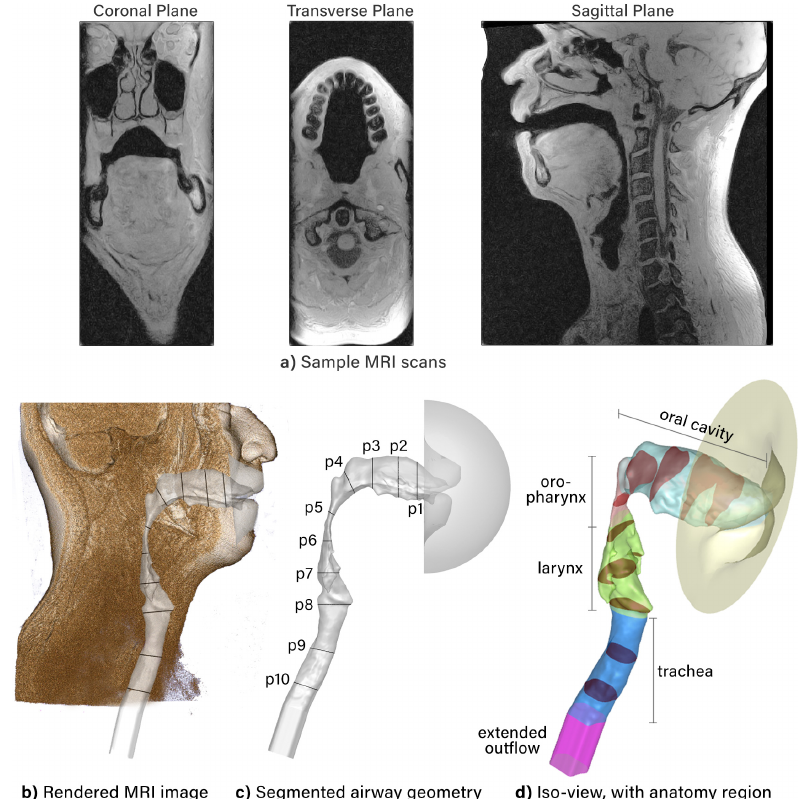
Figure 7. Airway geometry. ( a ) Sample MRI scans depicted in the coronal, transverse, and sagittal planes. ( b ) Three-dimensional rendered image from MRI scans with the segmented airway overlayed. ( c ) Segmented airway geometry labeled with cross-sectional planes (p1 to p10) from the oral cavity to the trachea. ( d ) Isometric view of the airway model showing the shape of the cross-section planes. Separated anatomical regions are colored as follows: light blue = oral cavity; red = oropharynx; green = larynx; dark blue = trachea; pink = extended